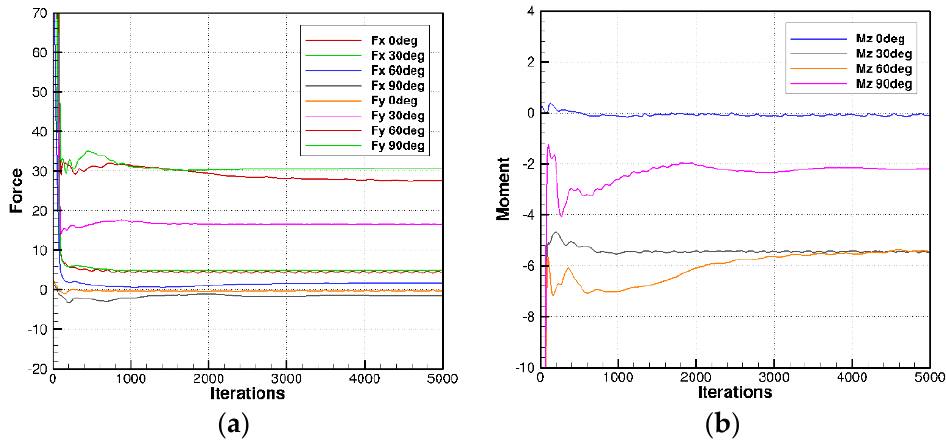
Figure 7. Convergence of forces and moments for the membrane-type LNGC, α = 0 °, 30°, 60°, and 90°. ( a ) forces; ( b ) moments.